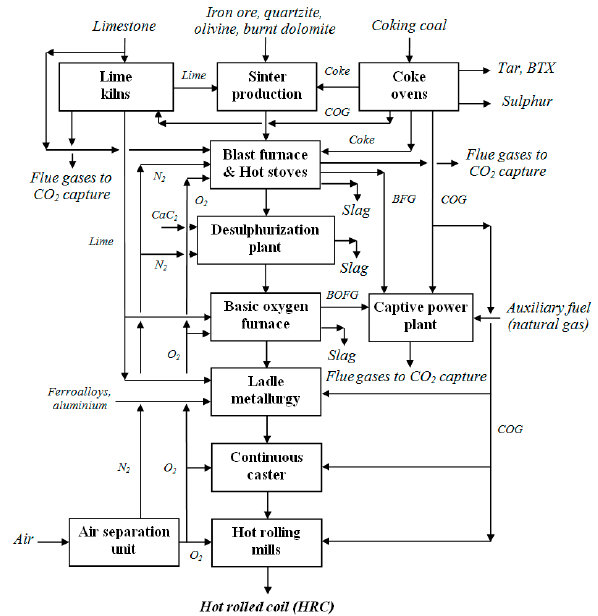
Figure 5. Decarbonized integrated steel mill.